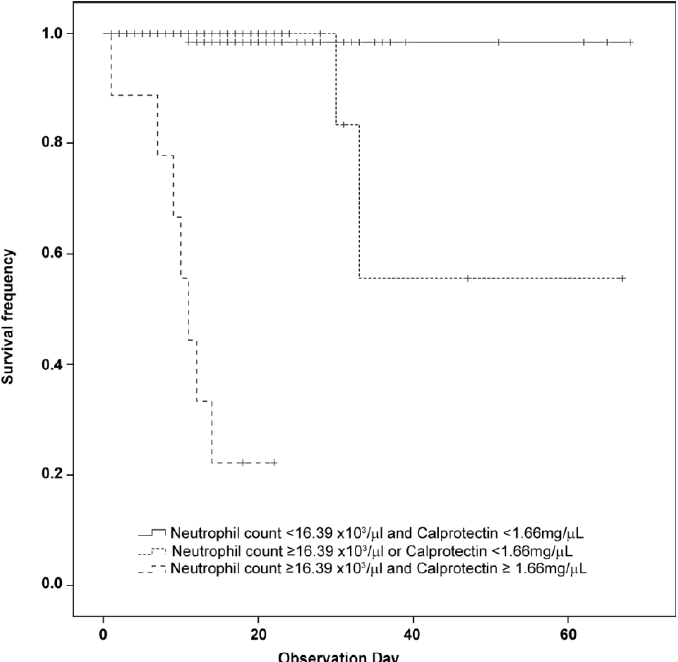
Figure 4. Kaplan–Meier survival curves of patients in relation to both calprotectin levels and neu- trophil count. Patients were divided based on levels over the cut-off for both calprotectin and neutrophil count, levels over the cut-off for only one of the parameters or levels below the cut-off for both parameters. Calprotectin cut-off at the first measurement: 1.66 mg/L. Neutrophil count cut-off at the first measurement: 16.39 × 10 3 /µL. Each vertical drop of the curve represents a single event. Plus signs indicate censored cases.